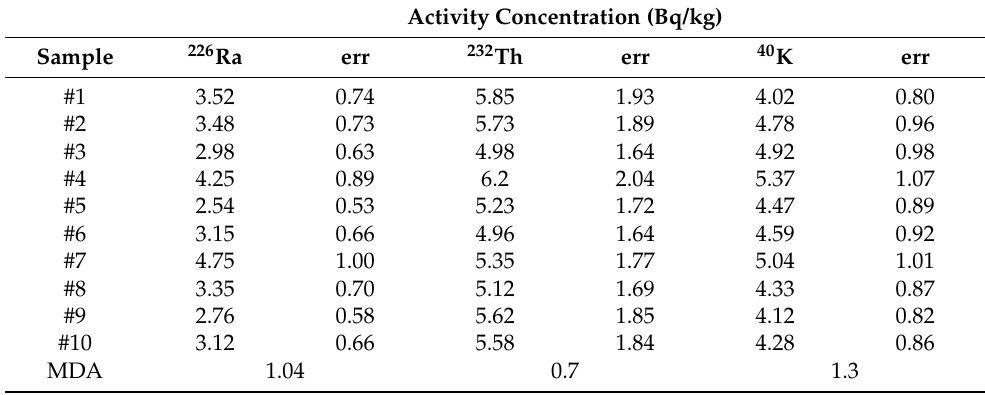
Table 1. Values of activity concentration of 10